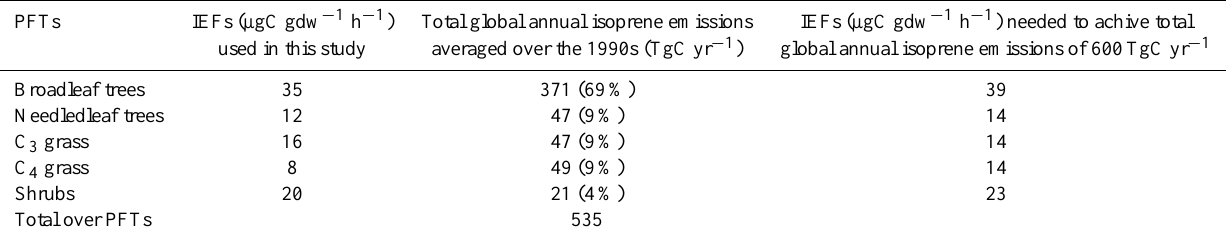
Fig. 5. Comparison of simulated and ground-based measured seasonal cycle of daily mean isoprene emissions (Pressley et al., 2005) and LAI (Pressley et al., 2006) at UMBS for 2000 and 2002. Table 4. Sensitivity of total annual emissions to the specification of PFT-specific